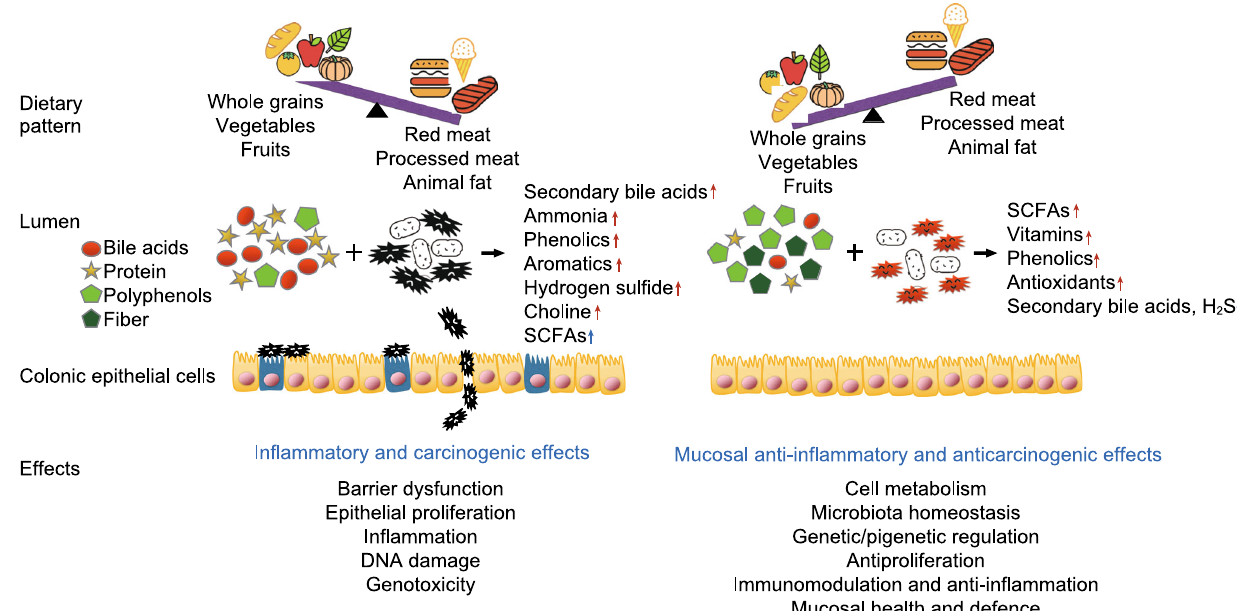
Figure 2. Diets in fl uence CRC risk via gut microbiota and associated metabolites. This fi gure shows the effect of two different types of dietary patterns on gut microbiota and associated metabolites. Gut bacteria can promote CRC by metabolizing oncogenic dietary/digestive components such as protein and bile acids into metabolites such as secondary bile acids and hydrogen sul fi de. In contrast, gut microbiota can protect against CRC by metabolizing bene fi cial dietary/digestive components such as plant-based polyphenols and fi ber into metabolites such as butyrate. Bacteria and their metabolites can have direct effects on colonocytes via barrier dysfunction, epithelial proliferation, in fl ammatory, DNA damage, genotoxic ways,